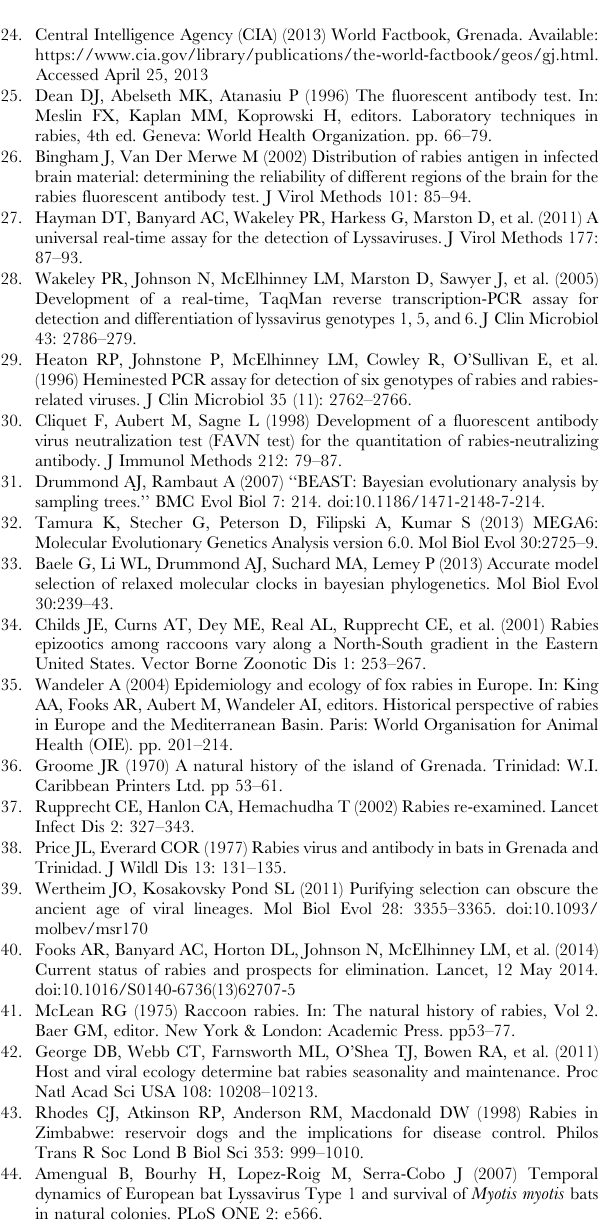
Figure S3 Maximum likelihood phylogenetic tree, comparing the same 1350 bp N-gene sequences as in Figures 3 and S1 using the same TN93 nucleotide substitution model with rate variation among sites and a proportion of invariant sites. Bootstrap values (percentage of 100 replicates) are given at significant